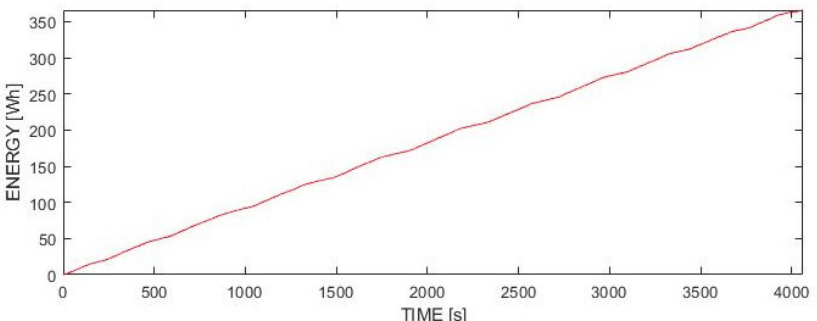
Figure 13. Energy consumption during experiments in Jazbina vineyard.